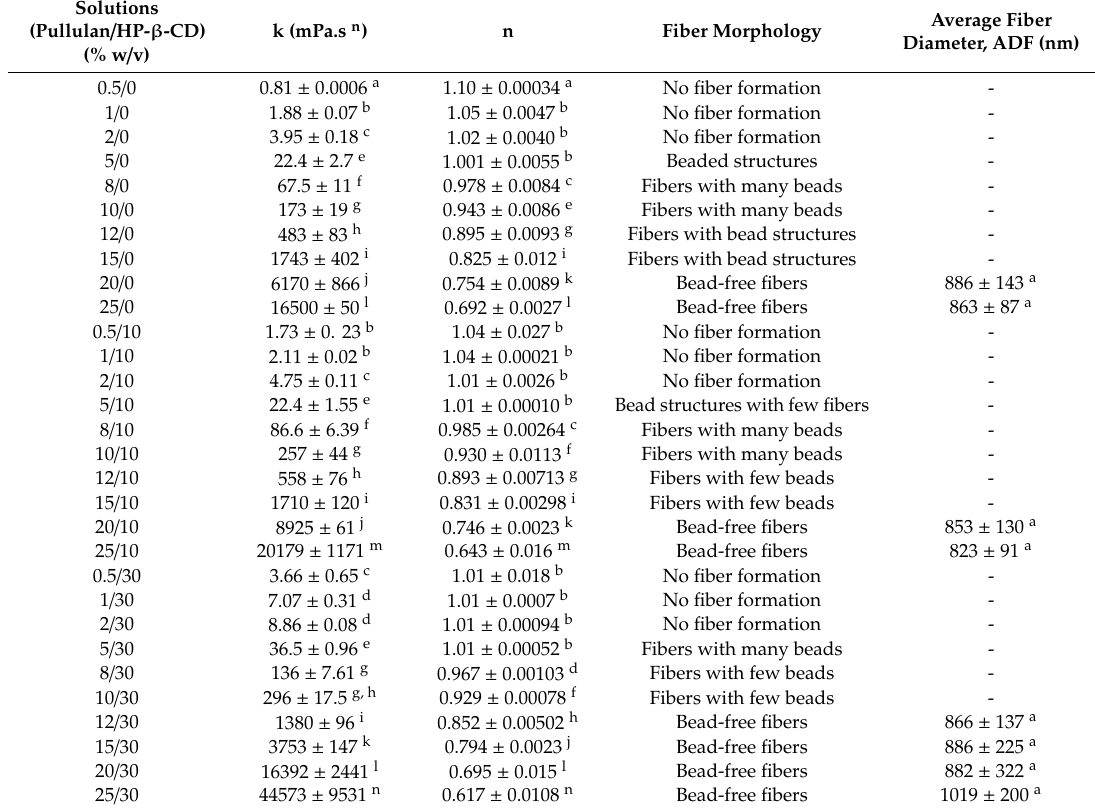
Table 1. Rheological properties of pure pullulan and pullulan / HP- β -CD solutions and morphology and average diameter of resulting